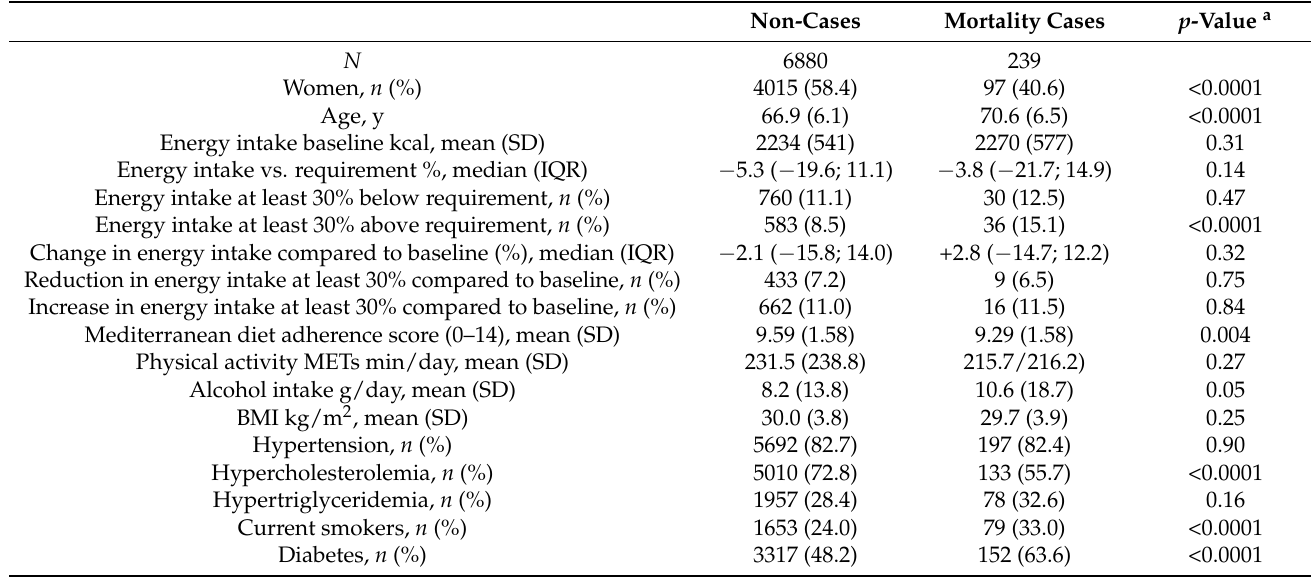
Table 1. Baseline characteristics of the participants included in the analysis sample 1 ( N = 7119), by mortality status, PREDIMED